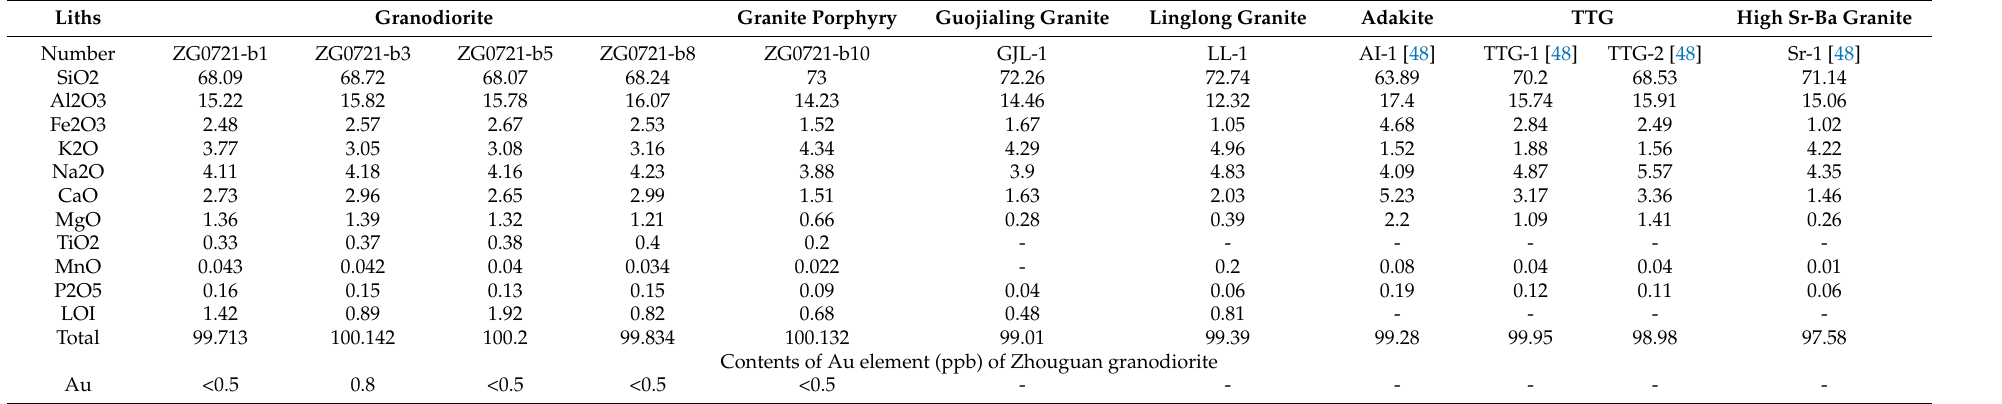
Table 1. Contents of major elements (%) of the Zhouguan granodiorite samples.